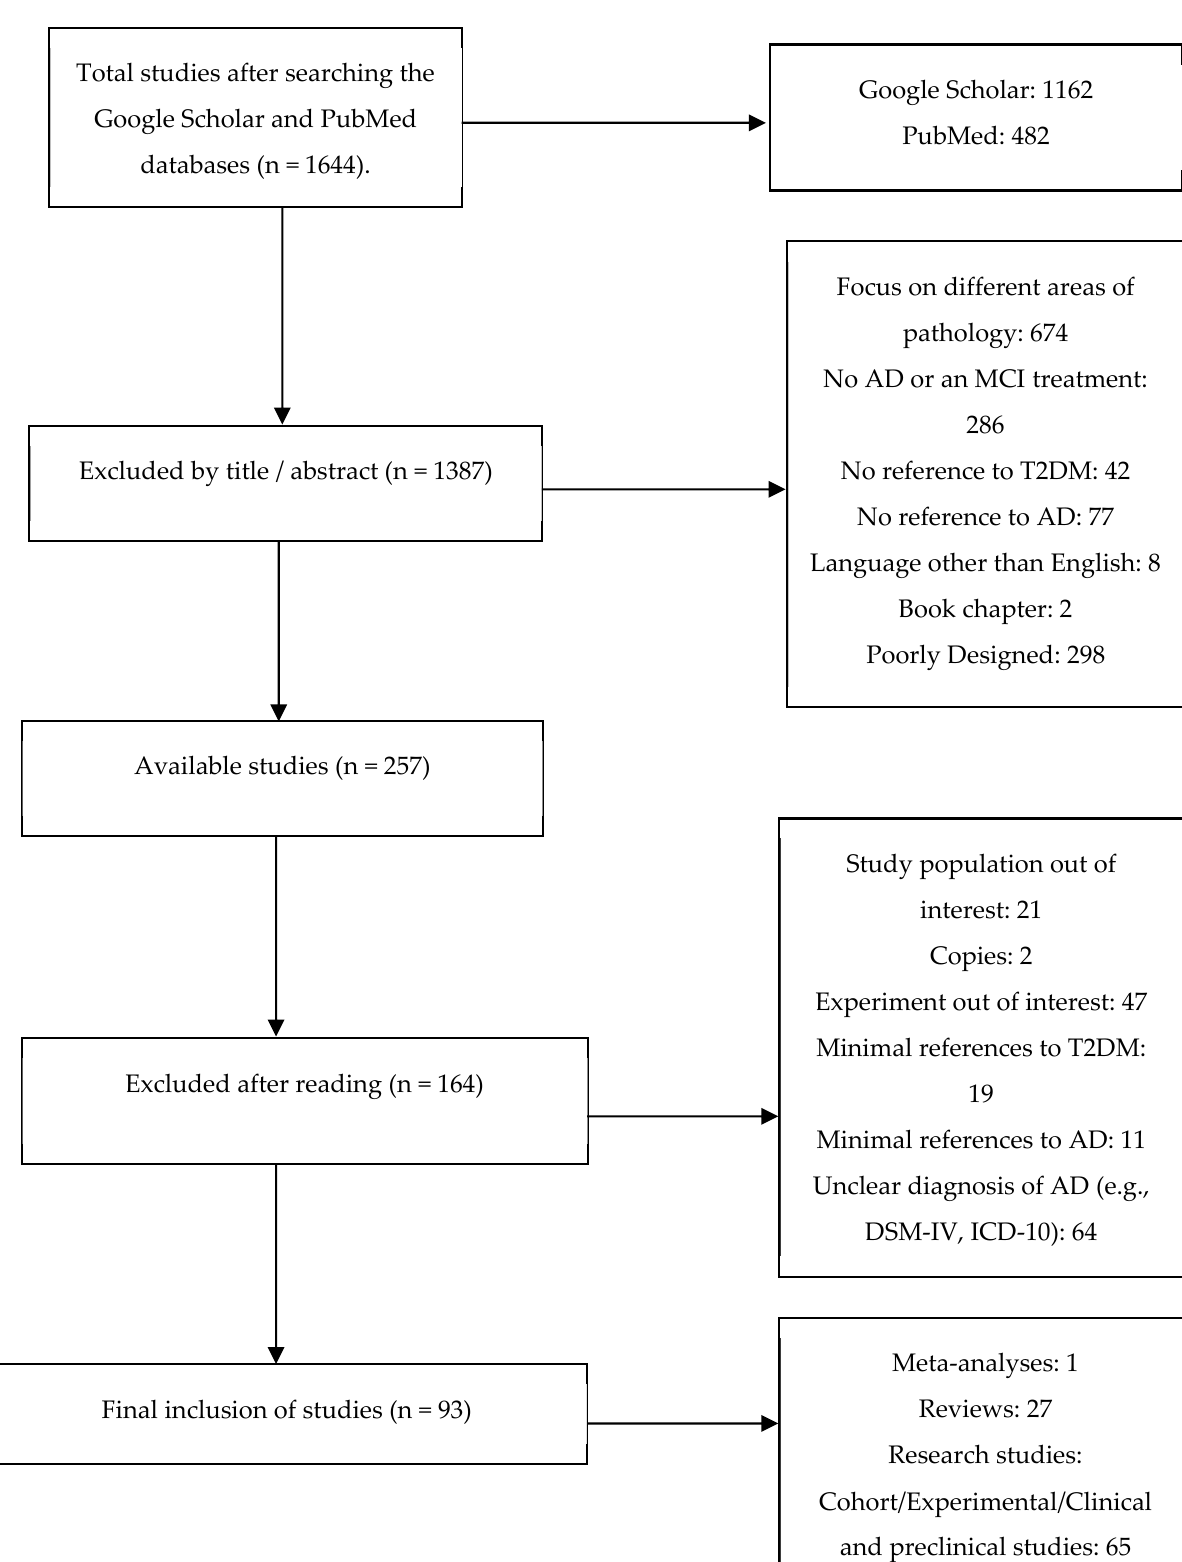
Figure 1. PRISMA flowchart of study selection.